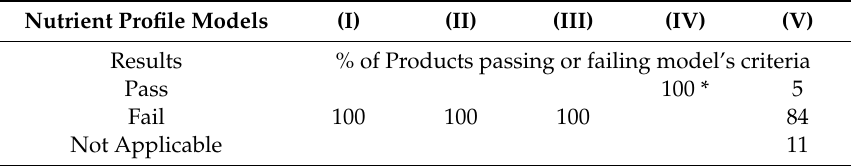
* The score varied between 17 and 23